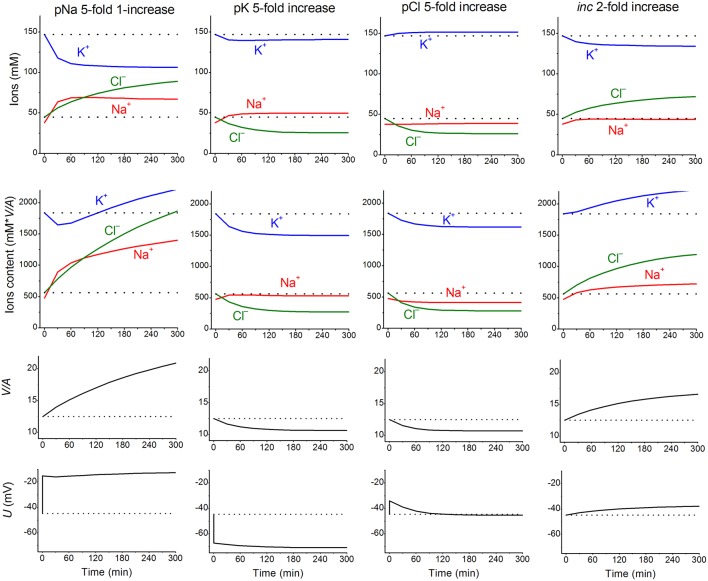
The calculated effects of an abrupt increase in the permeability coefficients of K+, Na+, Cl− channels, or the NC cotransport rate coefficient on cell K+, Na+, and Cl− content and concentrations, water-volume (V/A) and MP (U). The data were calculated by using the software BEZ01B. The initial parameters were na0 140, k0 5.8, cl0 116, B0 48.2, kv 1, beta 0.039, gamma 1.5, pna, 0.00382, pk 0.022, pcl 0.0091, inc 0.00003, ikc = inkcc = 0, kb 0, and hp 300, i.e., much like U937 cells; the changed parameters are shown on the plots.